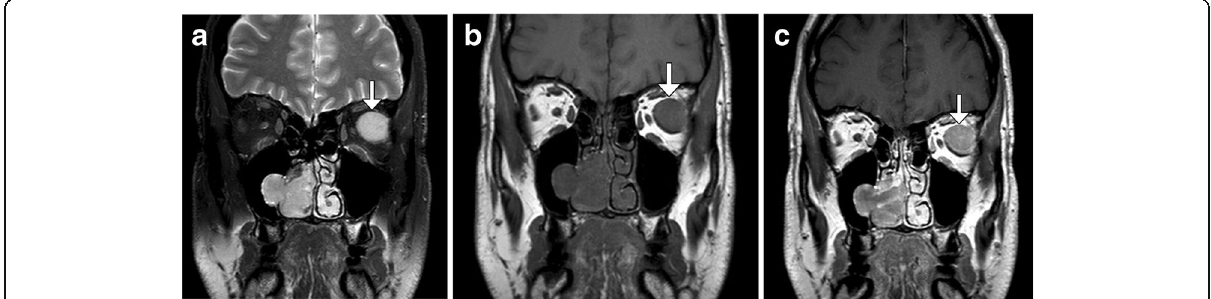
Fig. 16. Metastatic mucosal melanoma. Coronal T2-weighted ( a ), T1-weigthed ( b ), and post-contrast T1-weighted ( c ) MR images show am enhancing high T2 and intermediate T1 signal right sinonasal mass with extension into the right maxillary sinus via a secondary ostium and a left lateral rectus metastasis